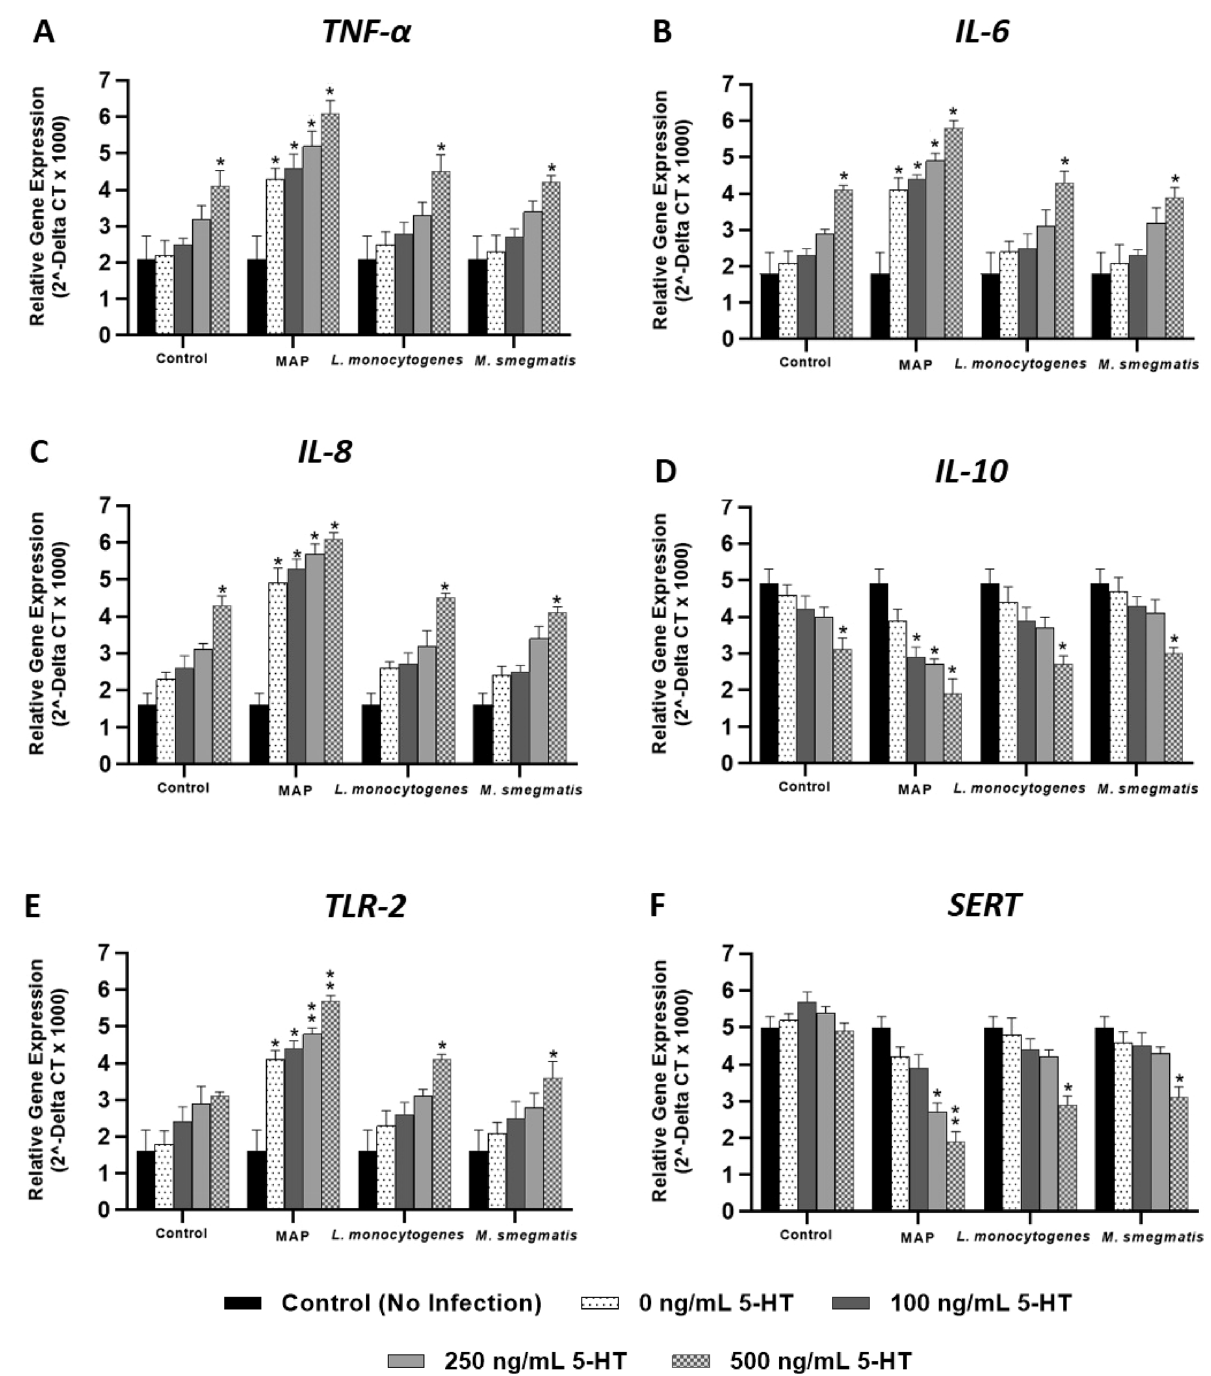
Figure 3. Effects of enteropathogenic bacterial infections on expression of TNF-α ( A ), IL-6 ( B ), IL-8 ( C ), IL-10 ( D ), TLR-2 ( E ) and SERT ( F ) in Caco-2 monolayers exposed to exogenous 5-HT levels (0, 100, 250 and 500 ng/ mL) for 24 h. Values were pre-tested for normal distribution using the Kolmogorov–Smirnov normality test. Significance among experiments was assessed by two-way analysis of variance (ANOVA) followed by Bonferroni correction test. All RT-PCR experiments were performed in triplicates. Data are presented as Mean ± SD. * P value < 0.05. ** P value <